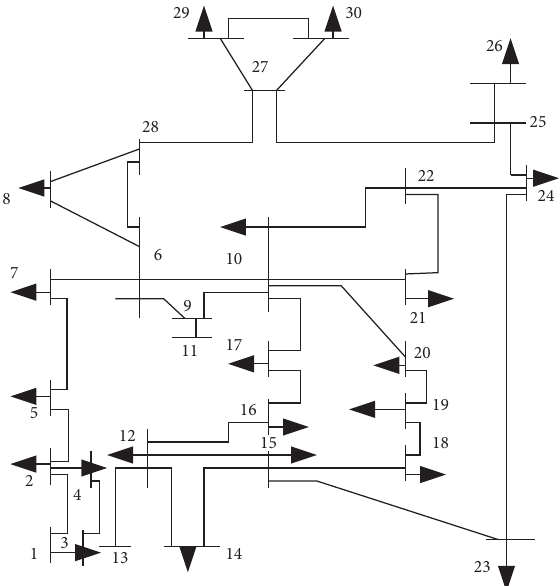
Figure 3: IEEE 30 node system wiring diagram.